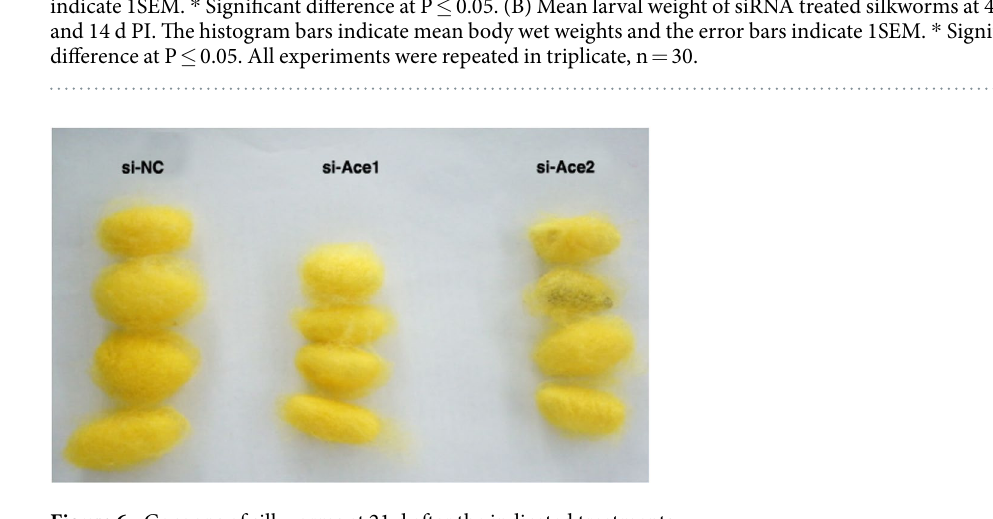
Figure 6. Cocoons of silkworms at 21 d after the indicated